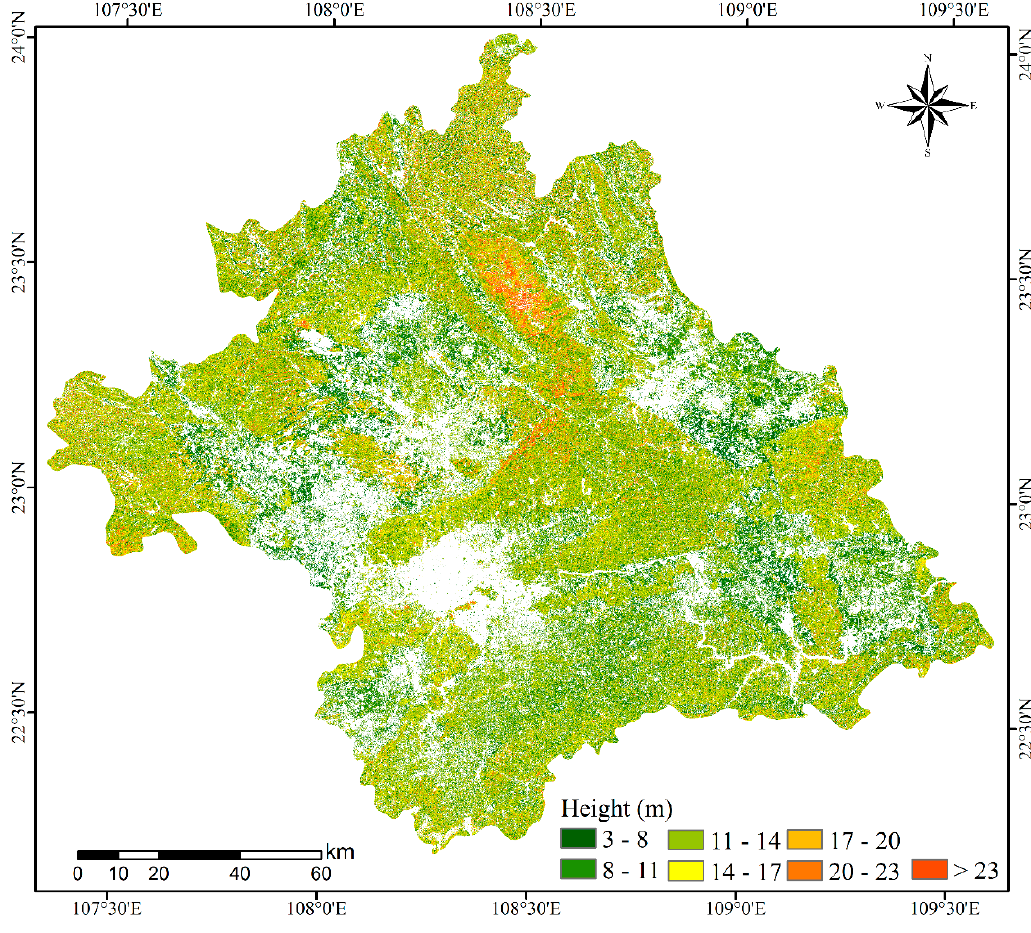
Figure 10. Forest canopy height estimated by the BP-ANN with training samples of the discontinuous CHM dataset.